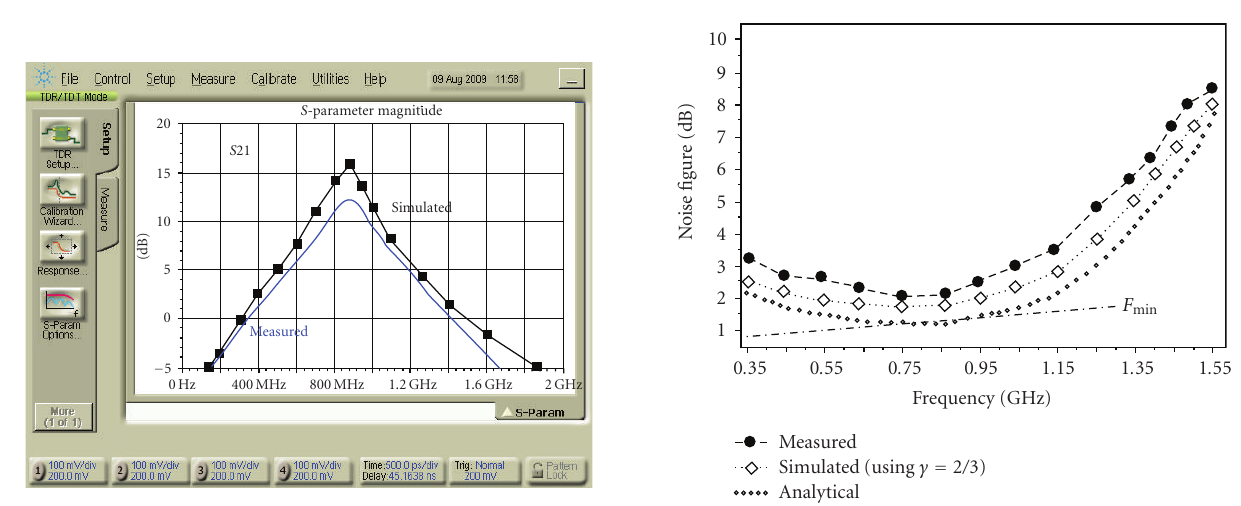
Figure 8: Noise figure ( NF in dB) of the RFID LNA.